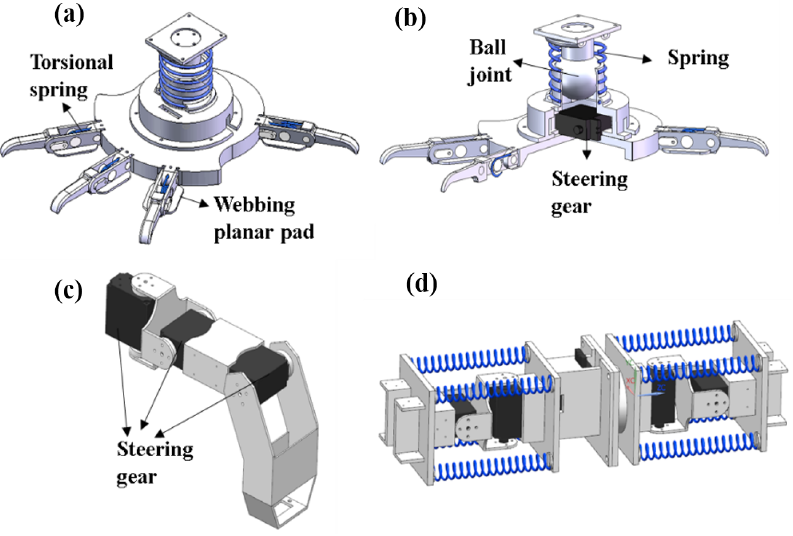
Figure 2. Bionic structures of the ( a ) foot, ( b ) broken-out section of foot structure, ( c ) leg, ( d ) and spine.